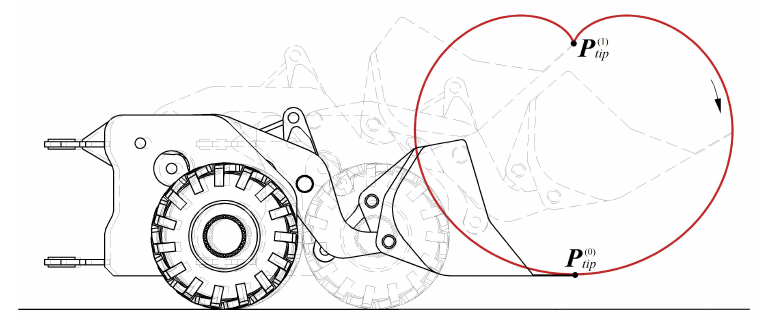
Figure 8. Motion process of working mechanism.